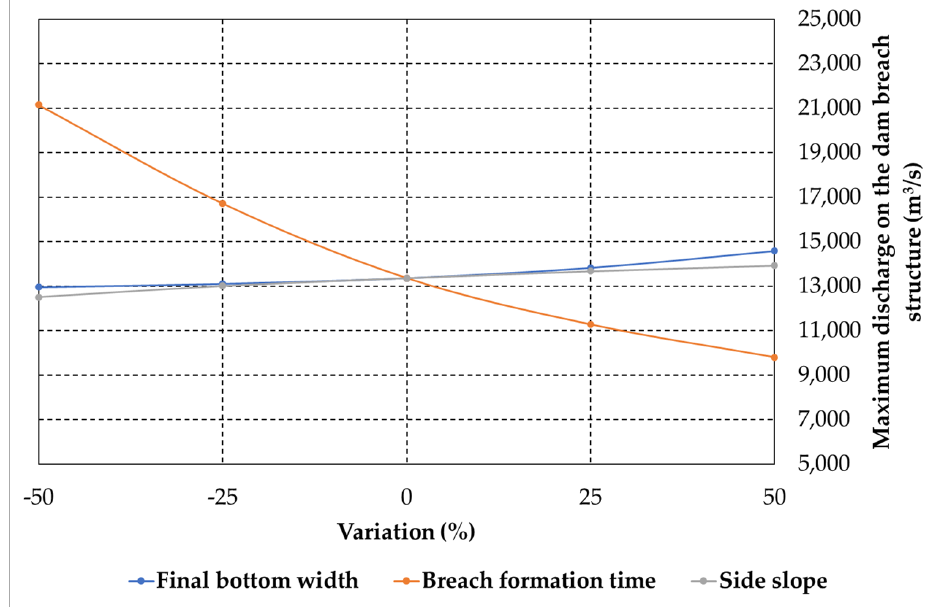
Figure 10. Maximum discharge on the dam breach structure for varying breach parameters.